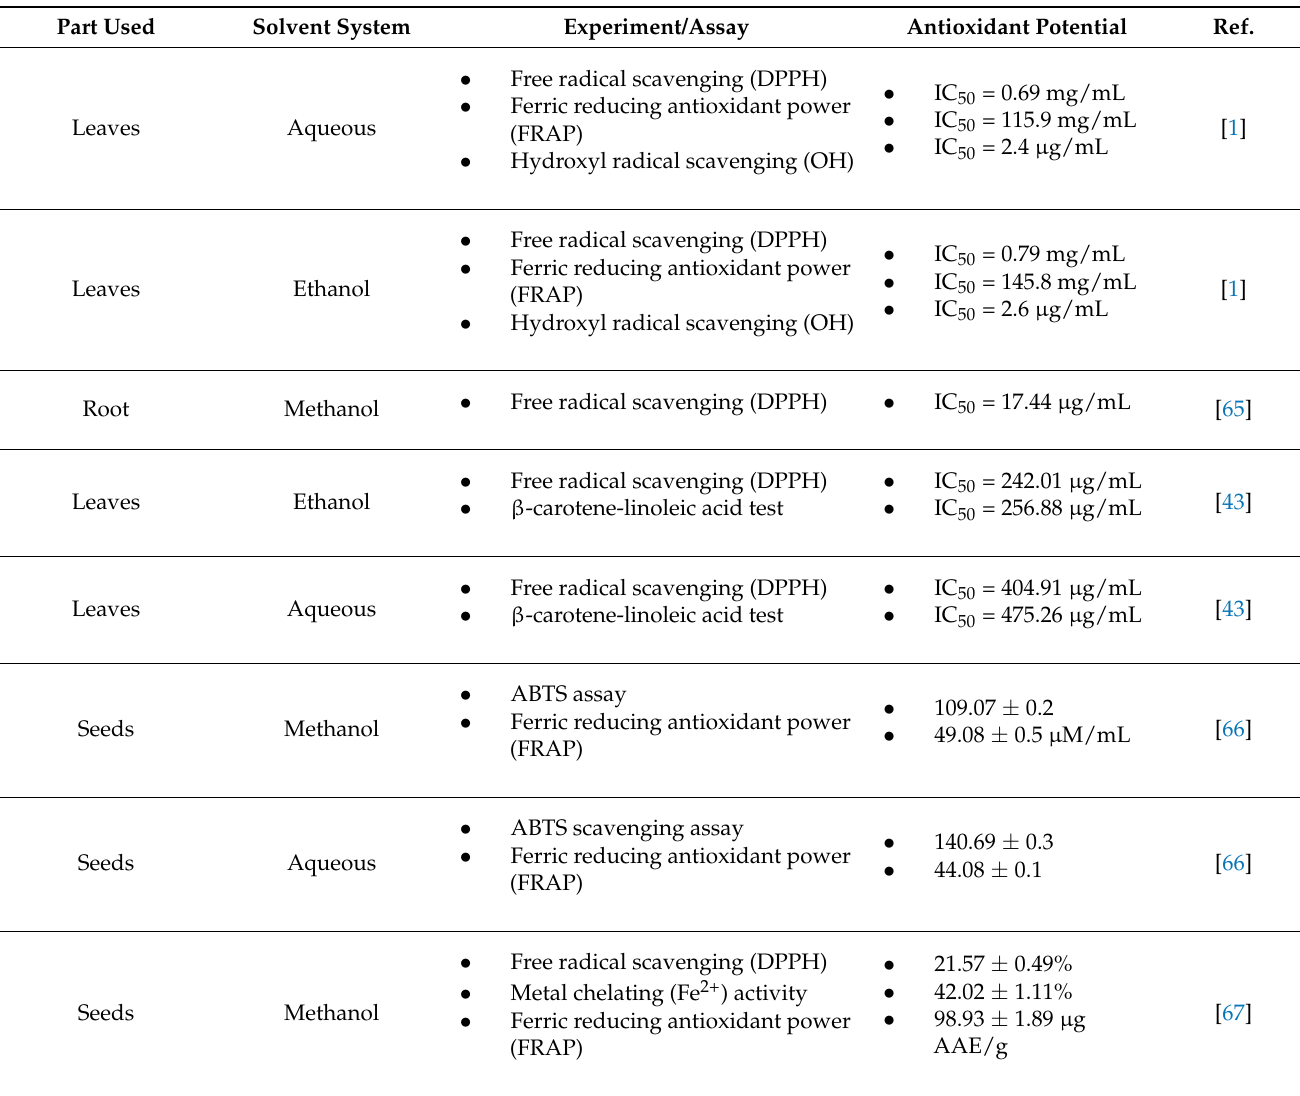
Table 11. Antioxidant potential of Cajanus cajan